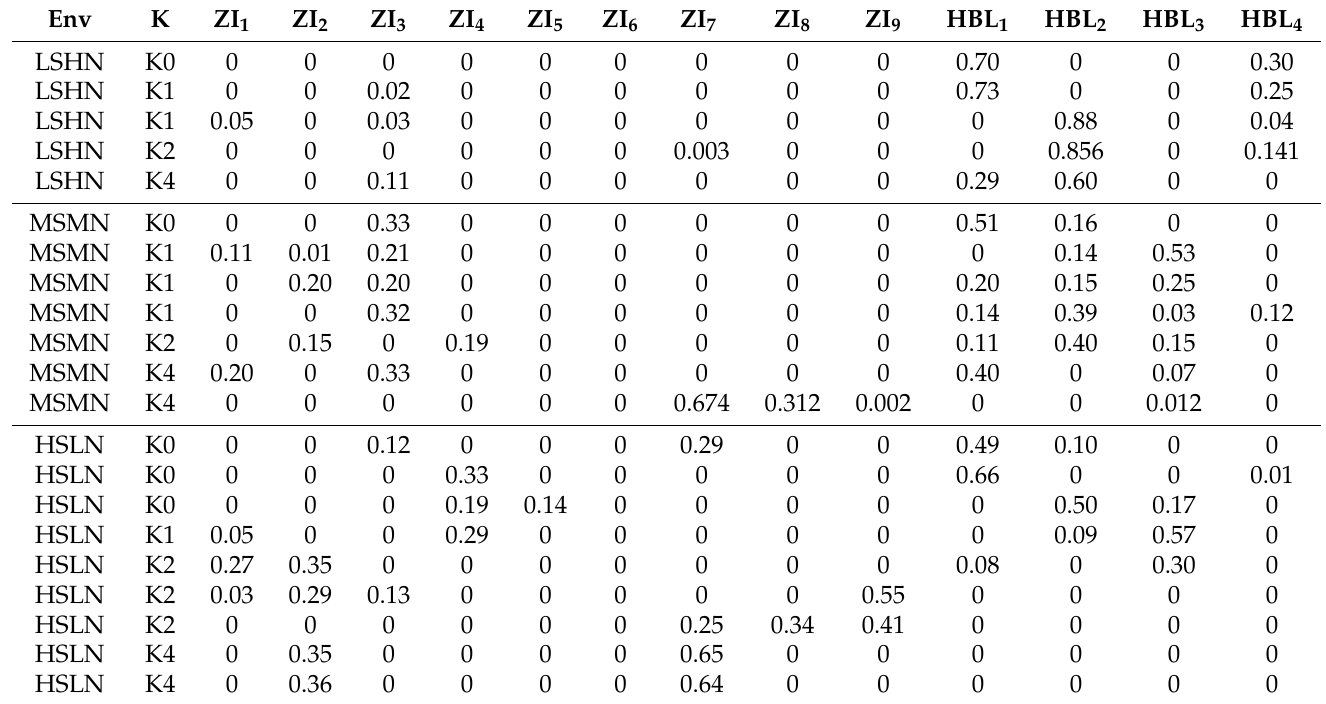
Table A13. Detailed equilibria for games where the exploiter does not spoof. Each row of the table describes one equilibrium found with its corresponding mixture of background strategies.